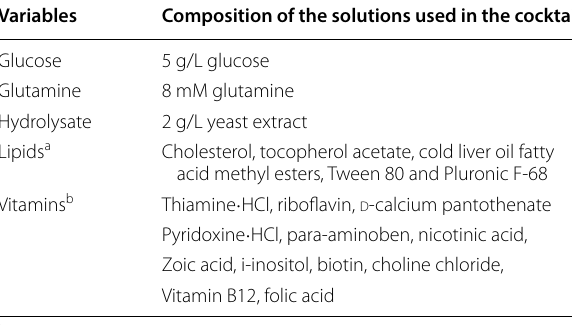
Table 1 Components of the feed